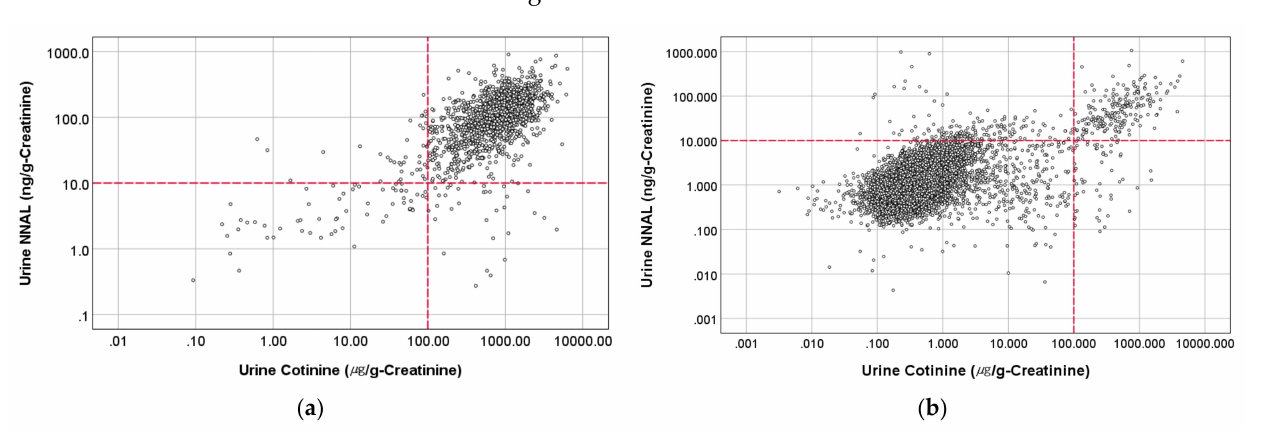
Figure 1. Condition of urinary NNAL and cotinine in ( a ) positive control (active smokers) and ( b ) non-smoker subjects.